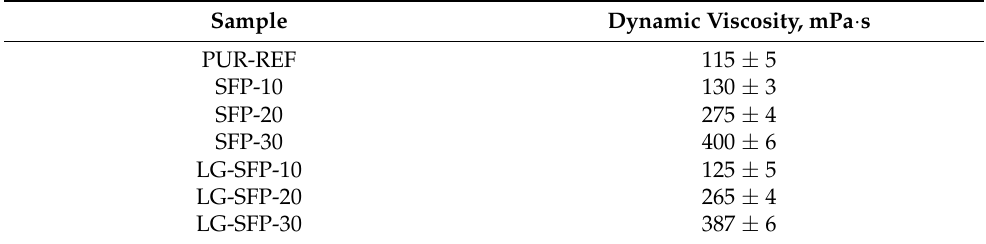
Table 2. Dynamic viscosity of PUR-REF, SFP, and LG-SFP modified PUR